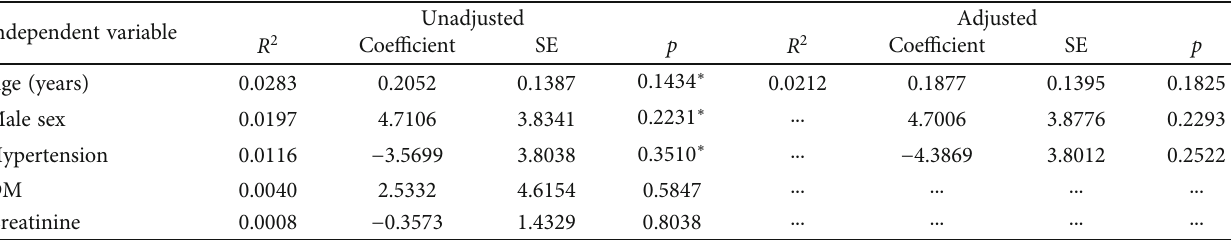
Table 2: Regression analysis of factors associated with troponin I in patients with non-ST-segment elevation myocardial infarction with type 1 myocardial infarction.